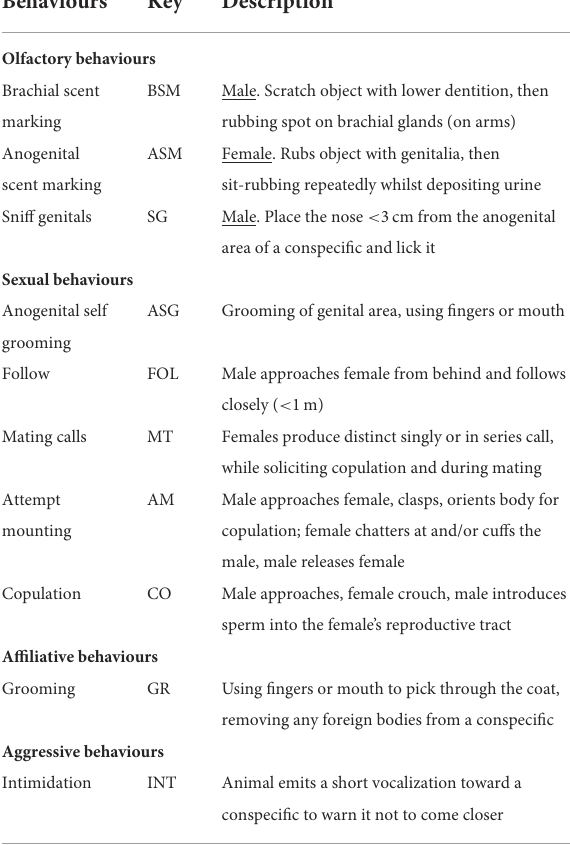
TABLE 3 Ethogram of selected behaviours for the study subjects.